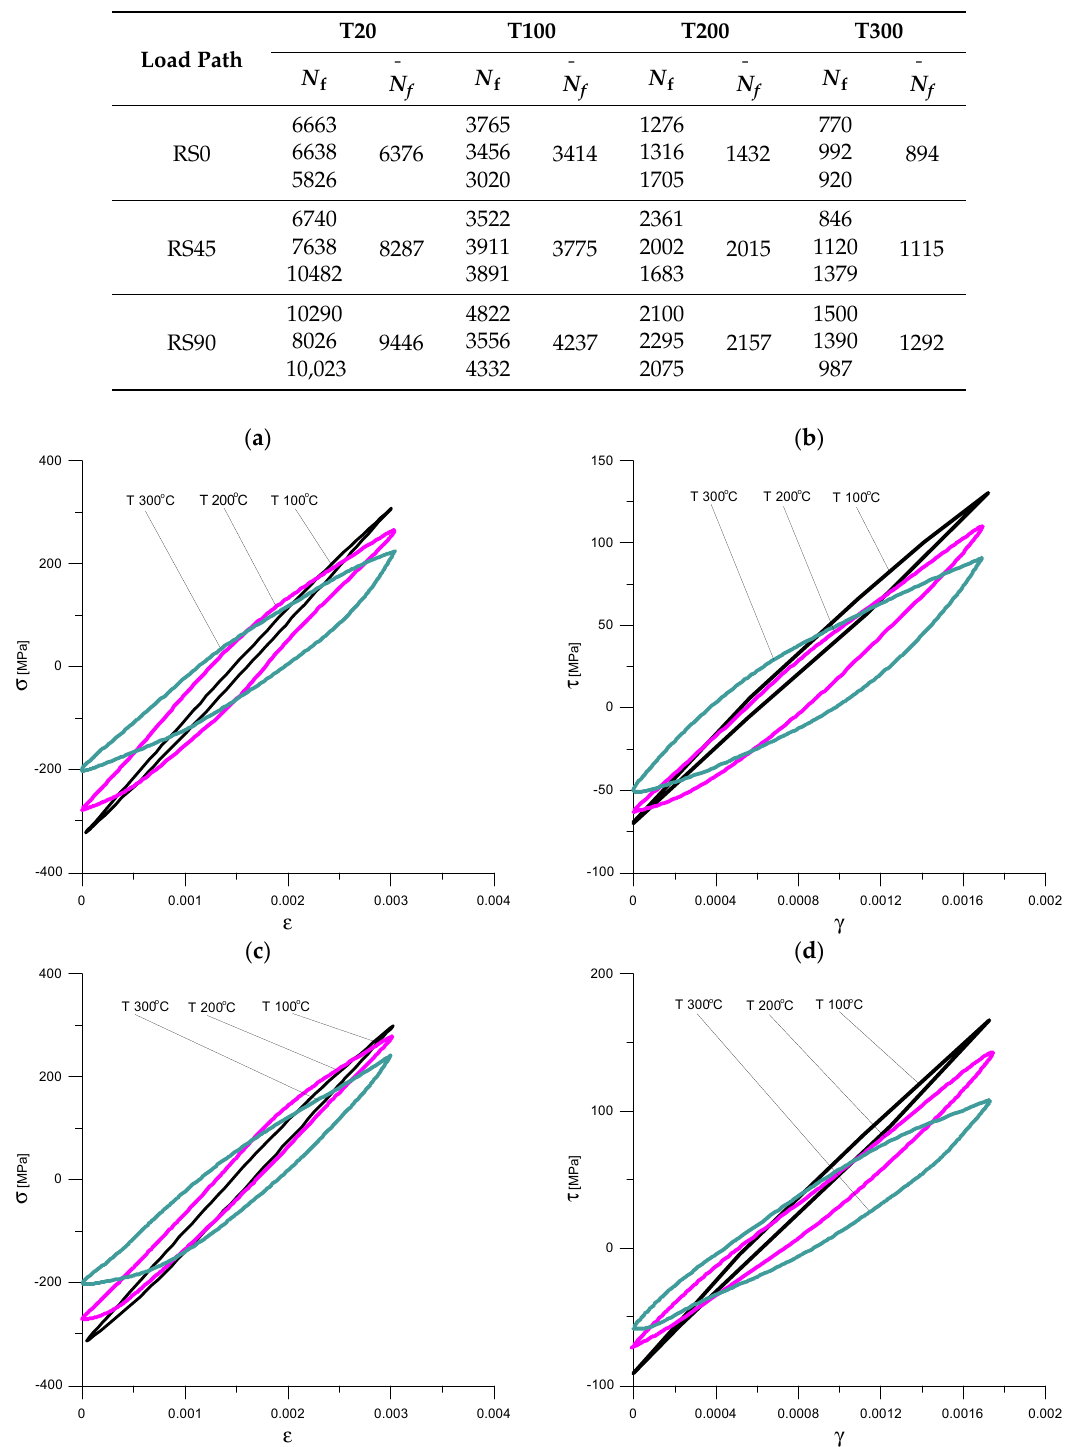
Figure 3. Hysteresis loops obtained at half of the fatigue life of the loading progression: ( a ) axial component for RS0; ( b ) non-dilatational component for various elevated temperature values for RS0; ( c ) axial component for RS45;( d ) non-dilatational component for various elevated temperature values for RS45.